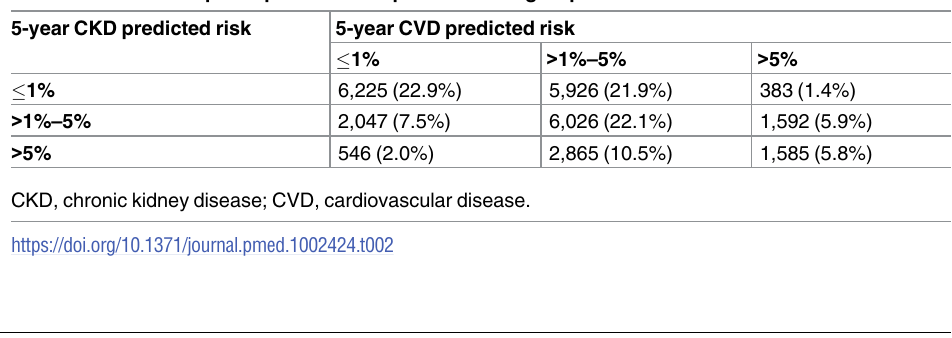
Table 2. Numbers of participants in each predicted risk group combination.